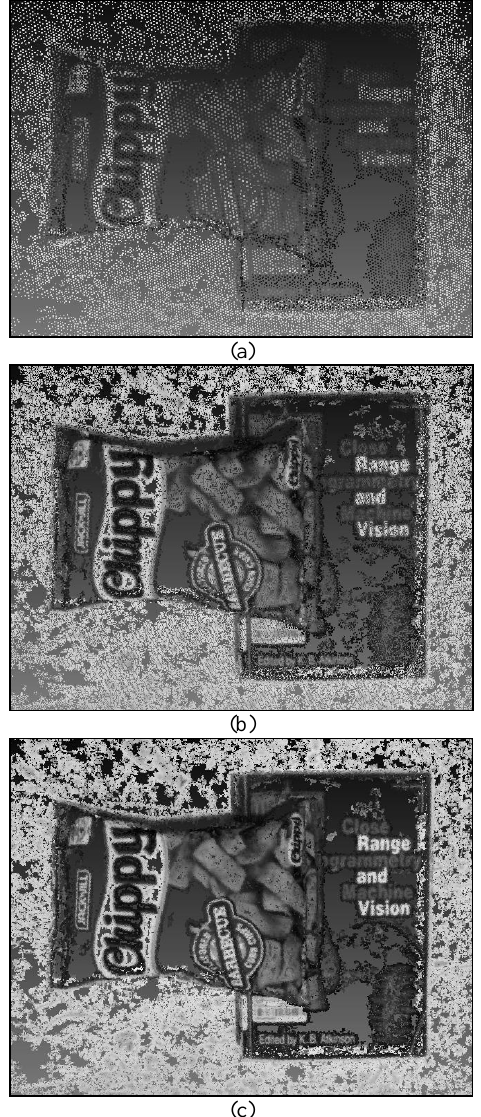
Figure 5: Comparison of 3D point cloud outputs from varying the values for maximum photo width: (a) 1200-pixel output; (b) 2000-pixel output; (c) 2700-pixel output